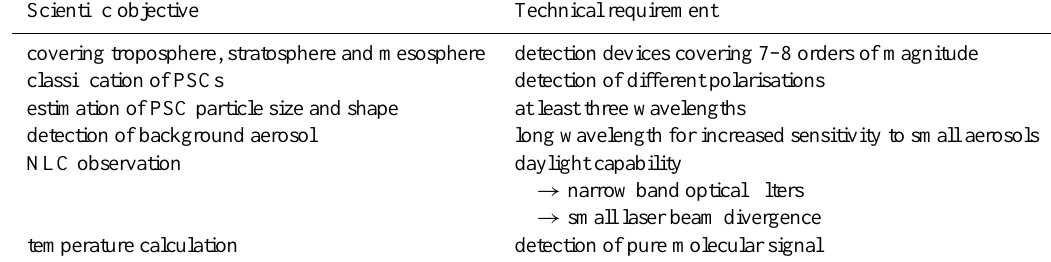
Table 1. Scientific objectives and necessary technical requirements on the U. Bonn lidar at the Esrange.